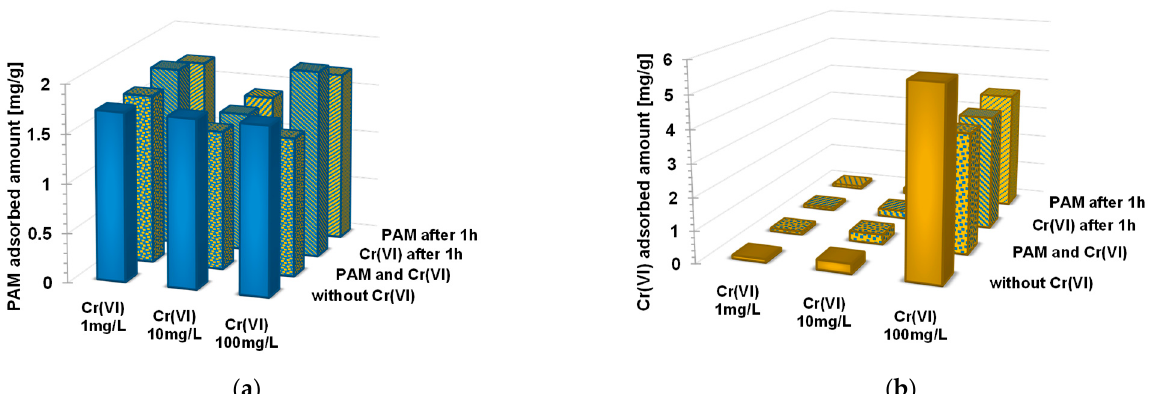
Figure 8. The effect of the order of adsorbate addition (AnPAM-30 and Cr (VI) with different con- centrations) on the adsorbed amounts of: ( a ) anionic polymer; ( b ) chromium anions adsorption on the kaolinite surface at pH 5, initial concentration of polyacrylamide is 100 mg/L.